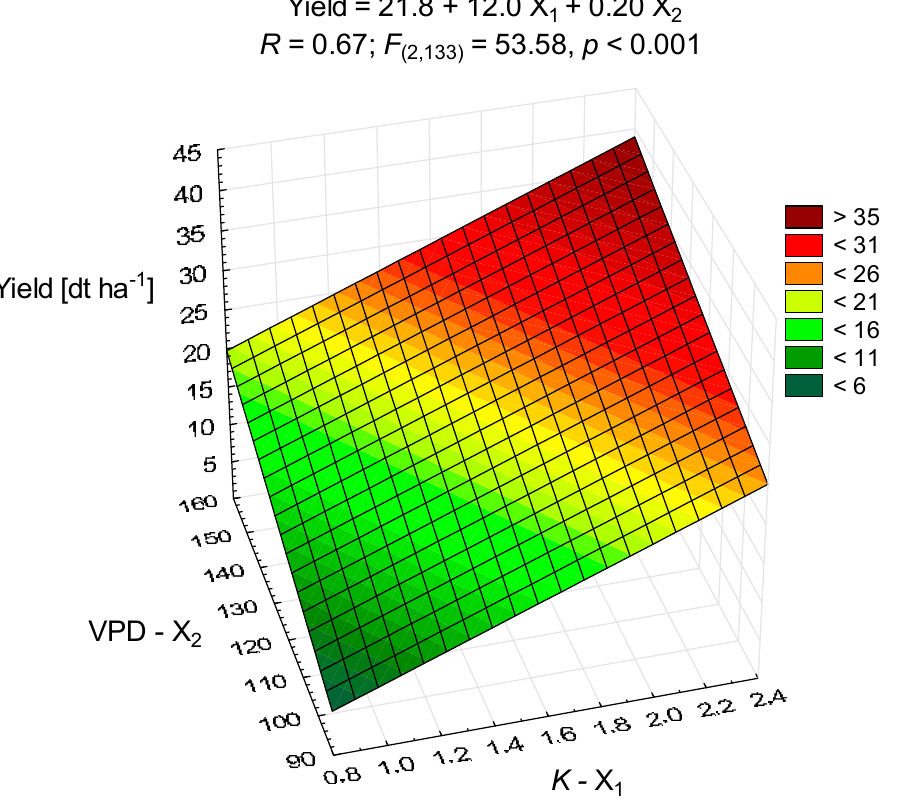
Figure 2. The relationship between soybean yield (dt ha − 1 ) and vegetation period in days (VPD) and hydrothermal coefficient ( K ) in Central Poland.